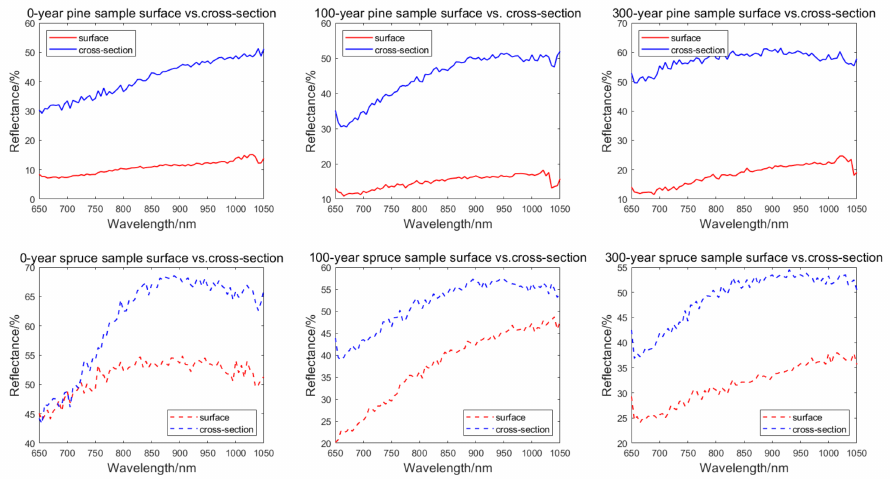
Figure 9. The reflectance comparison of surface and